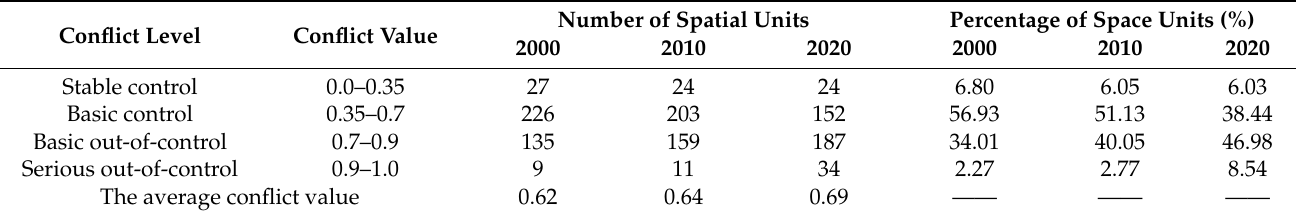
Table 5. Land-use conflicts level in the study area from 2000 to